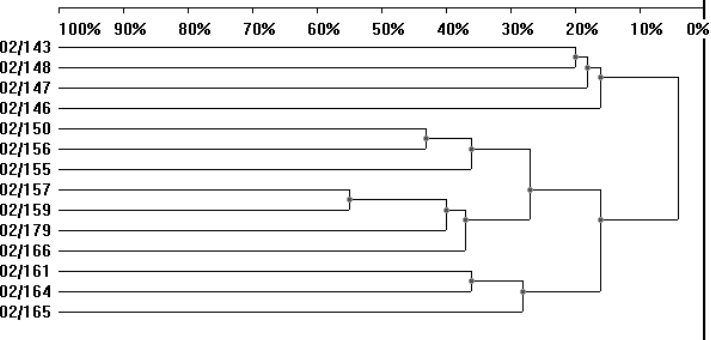
Fig.3. dendrogram of similarity among genotypes of H. abietinum.